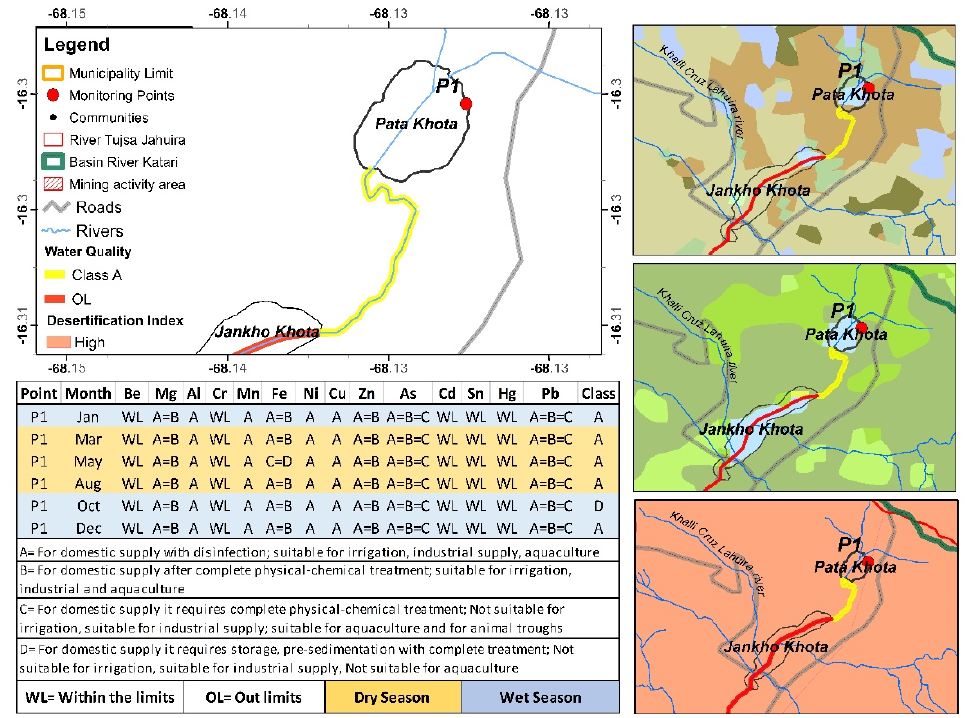
Figure 5. Water quality classification according to parameters monitored in P1—Milluni Basin .